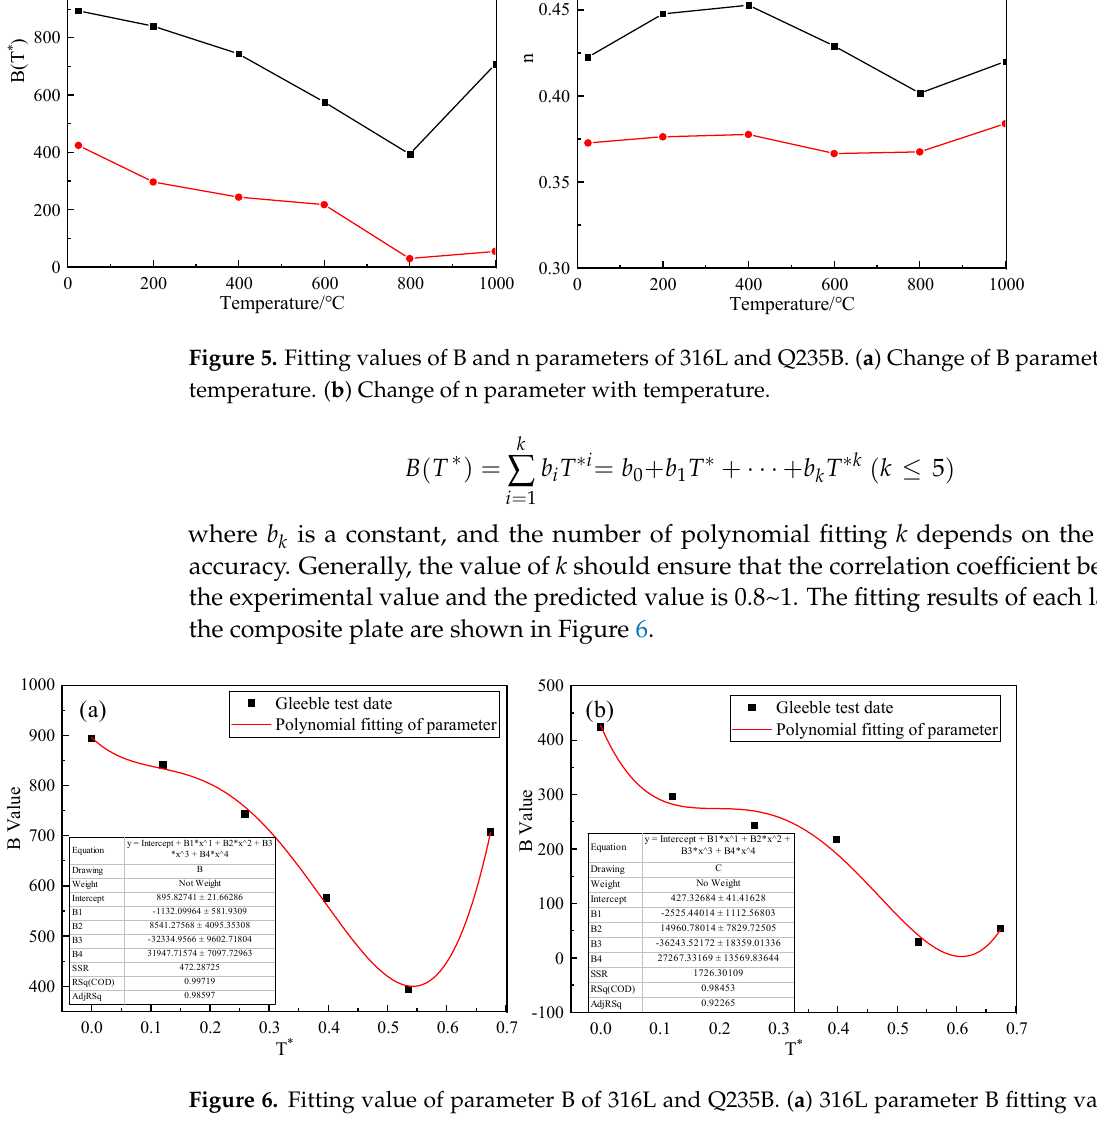
6 of 24 Figure 4. Parameter fitting of m and p of 316L and Q235B material constitutive models. ( a ) 316L; ( b ) Q235B. After calculation, the constitutive model parameters of the 316L were m = 0.524, and p = 0.825; the constitutive model parameters of the Q235B were m = 0.5083, and p = 0.9096. For the strain hardening rate parameters B ( T * ) and n of the thermoplastic constitutive model coupled with the temperature softening effect, it is necessary to use the real stress– strain curve data of the material at a high temperature to determine their values [25]. For specific temperature conditions, the relationship between flow stress and equivalent plas- tic strain is as follows: 𝜎 (cid:3365) = σ 0.2 + B 𝜀̅ n